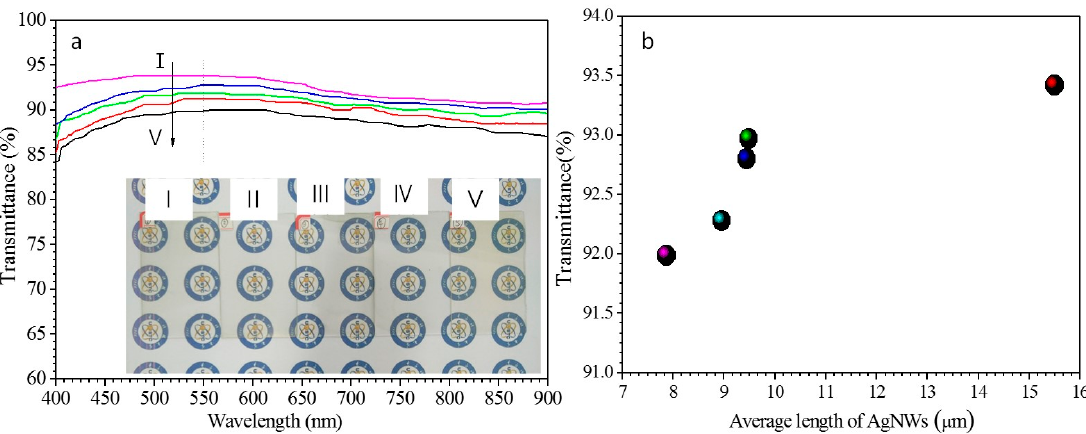
Figure 6. Transmittance ( a ) and transmittance at 550 nm ( b ) of AgNWs films consisting of the different lengths of AgNWs. The inset in ( a ) from I to V contains photographs of the films composed with AgNWs lengths of 15.5, 9.48, 9.24, 8.95, and 7.86 μ m, respectively.